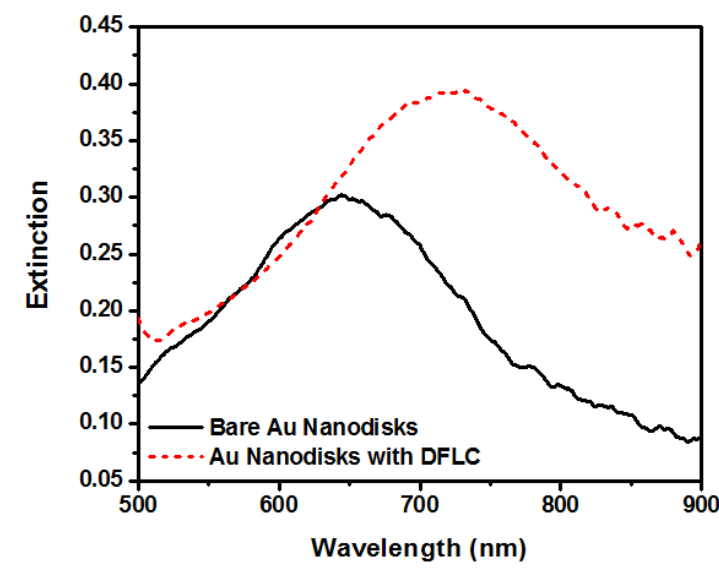
Figure 9. Comparison of measured extinction of nanodisks at normal incidence with and without dual-frequency liquid crystals (DFLCs). Reproduced with permission from [110]. Copyright American Institute of Physics, 2010.